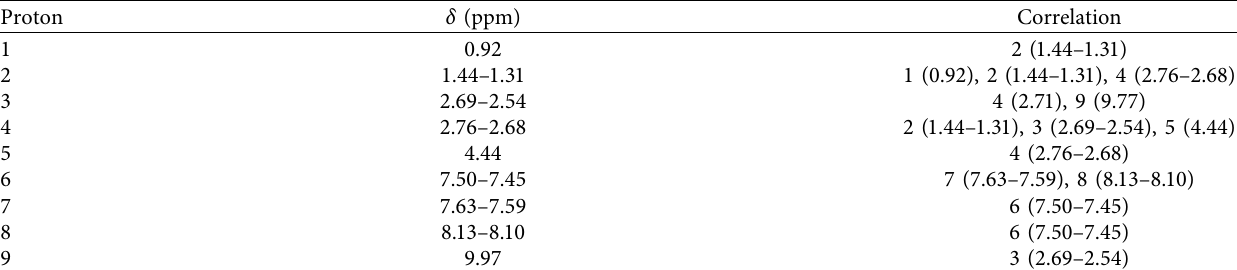
Table 2: Correlations for compound Michael adduct 3c in the COSY